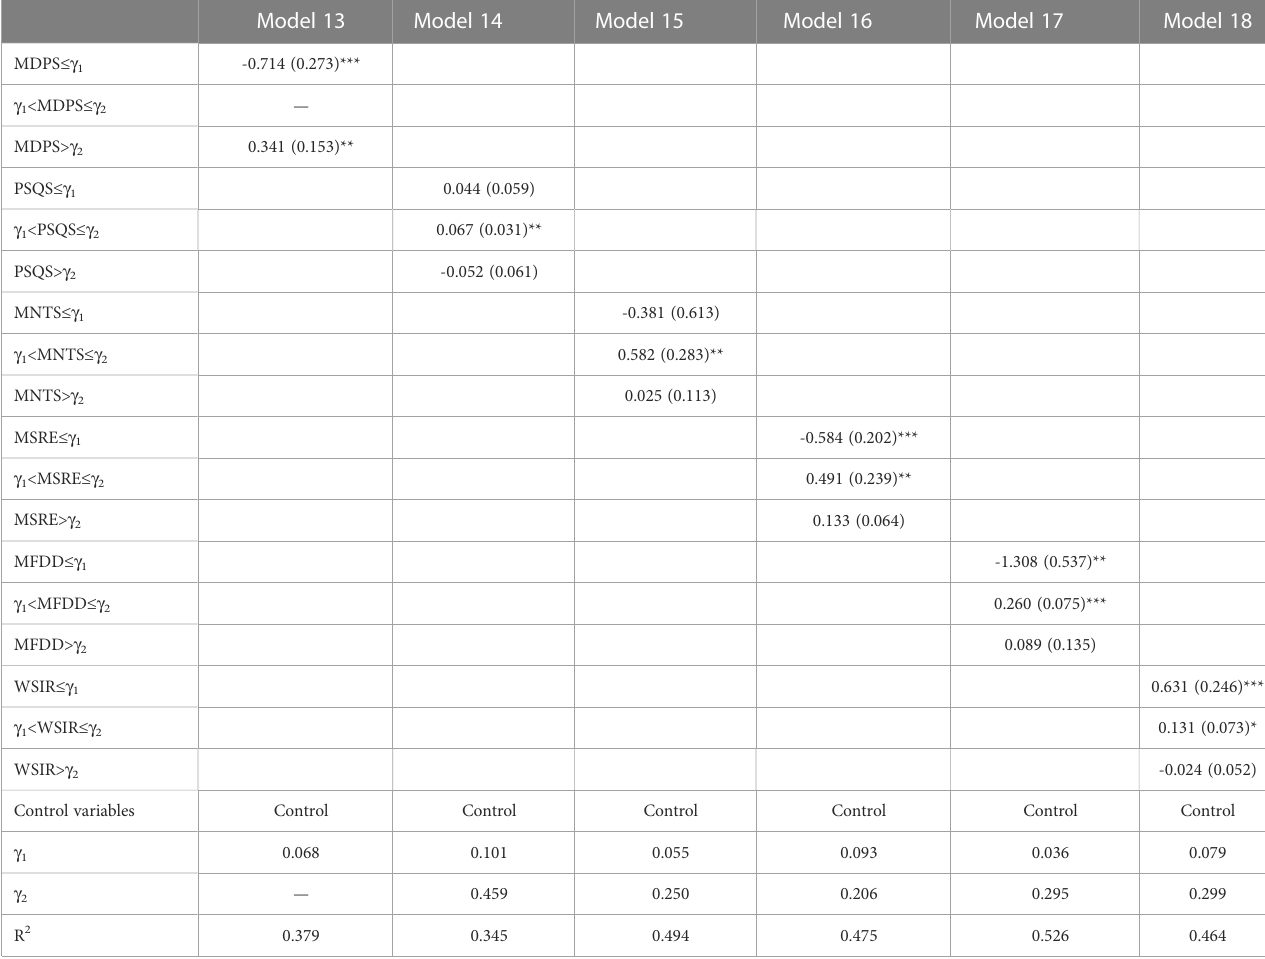
TABLE 3 The threshold model results of GTFPG in the non-major grain producing